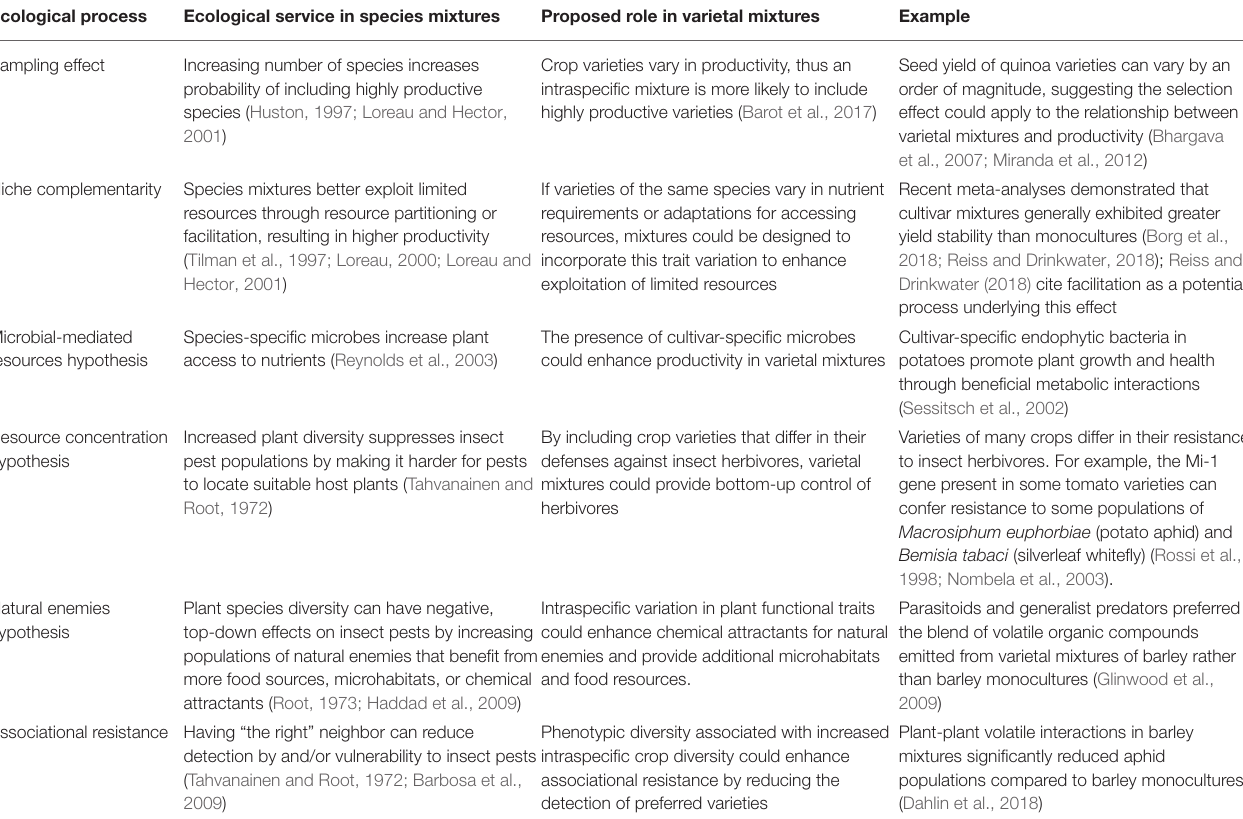
TABLE 1 | Summary of the services provided by ecological processes in species mixtures, the proposed role of these processes in varietal mixtures, and examples from the literature on varietal crop mixtures. Ecological process Ecological service in species mixtures Proposed role in varietal mixtures